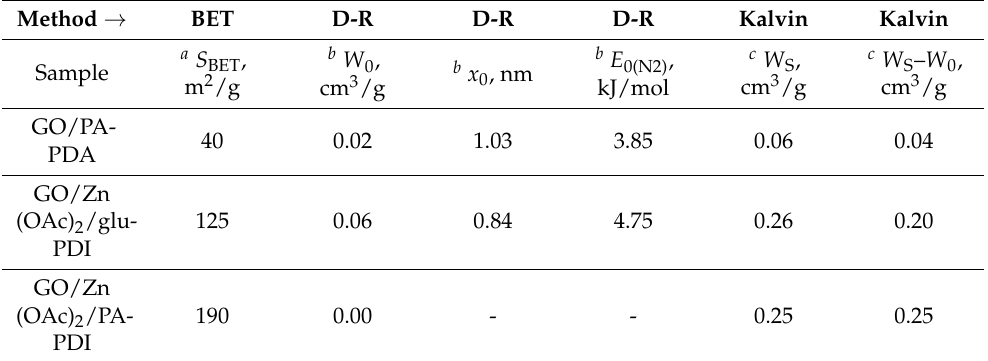
Figure 5. Raman spectra of ( 1 ) GO/Zn (OAc) 2 /PA-PDI and ( 2 ) GO/Zn (OAc) 2 /glu-PDI hybrid materials.